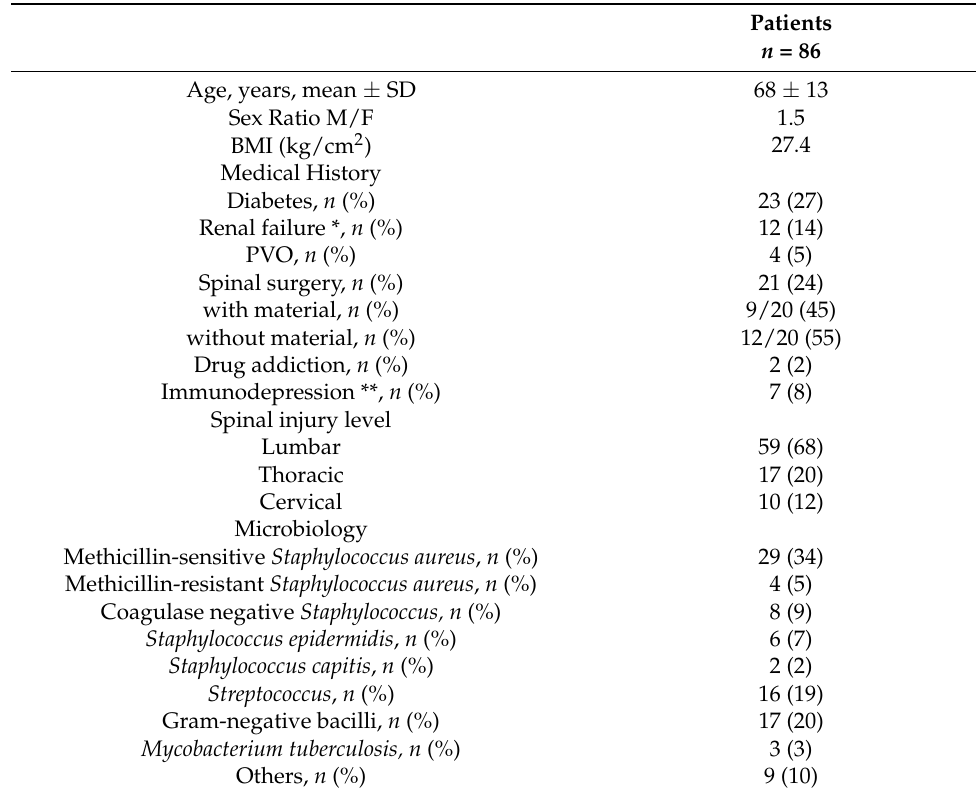
Table 1. Characteristics of patients.